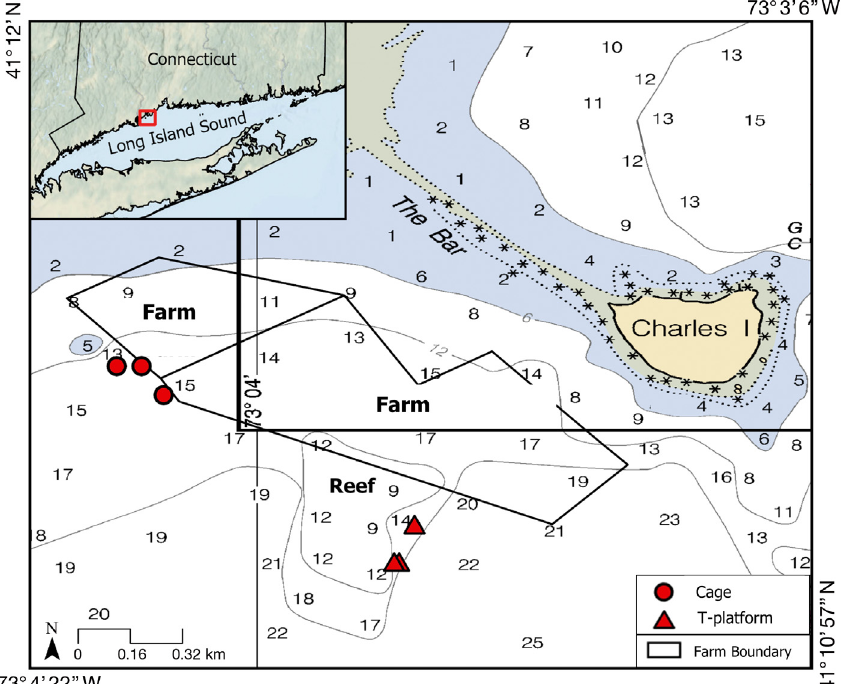
Fig. 1. Study sites included an on-bottom eastern oyster aquaculture cage farm and a natural cobble and boulder reef. Insert shows location of sites in central Long Island Sound near Milford, Connecticut, USA. The cage farm was adjacent to a commercial shellfish farm that contained 140 oyster aquaculture shelf-and-bag style bottom cages. Cameras were deployed on oyster cages at the cage farm and on T-platform stands adjacent to boulders on the rock reef. Numbers indicate depth in meters. Blue areas delineate shallow water and asterisks indicate